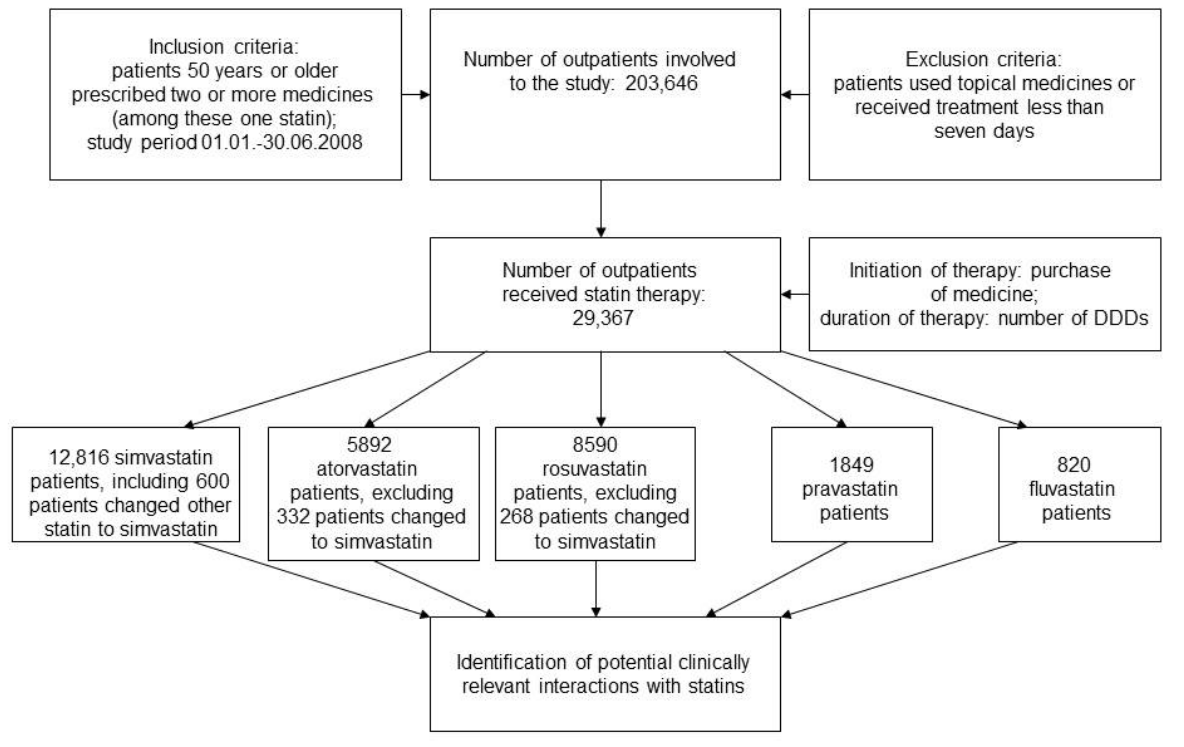
Figure 1: The study protocol and study